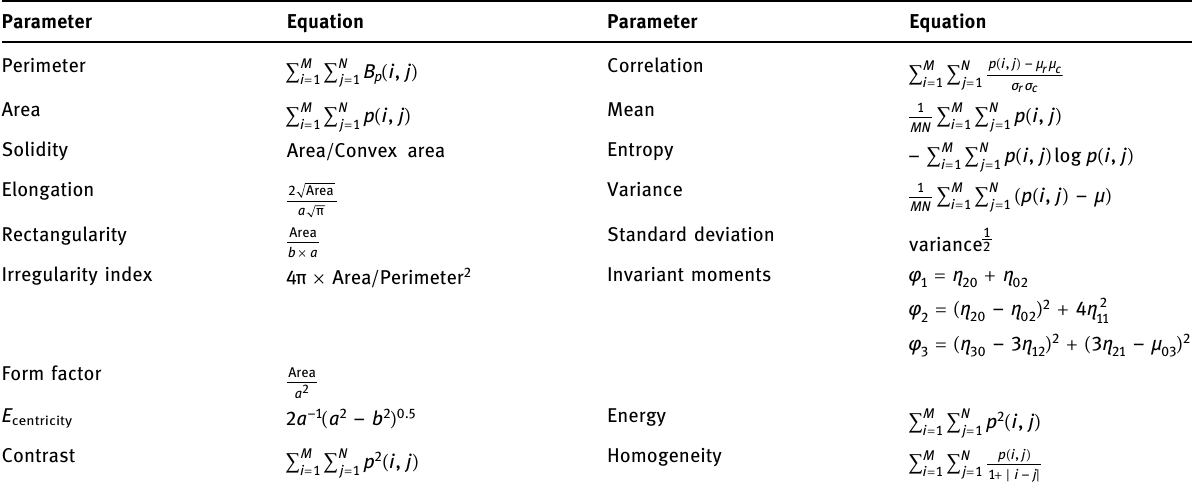
Table 3: Adopted features in this study